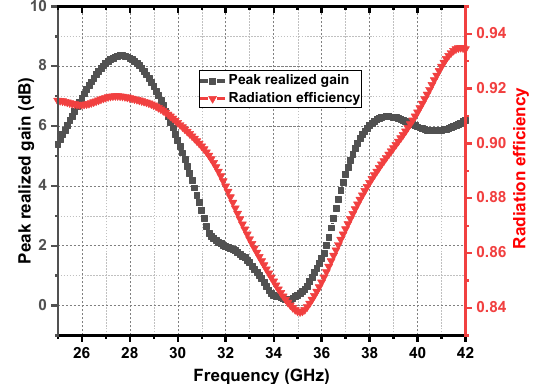
FIGURE 10. The MIMO antenna gain and radiation efficiency.